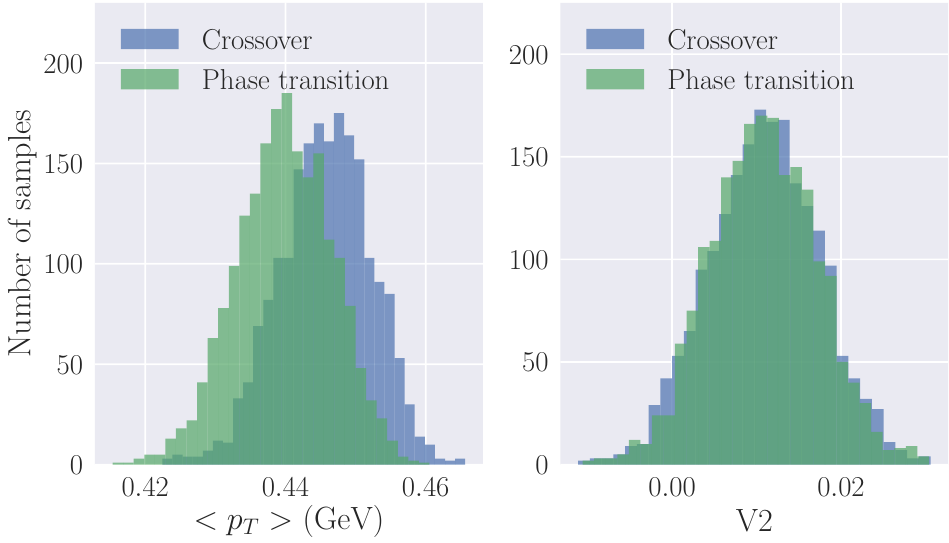
Figure 3 . (Color online) Distributions of Mean transverse momentum (left) and elliptical flow (right) for crossover and first order phase transitions. The values are averaged over all particles from 15 UrQMD events with b=0–7 fm ( Dataset-1 ). The distributions have significant overlap that it is not possible to classify the EoS using these observables while the DL model with 15 event combined input achieved an accuracy of